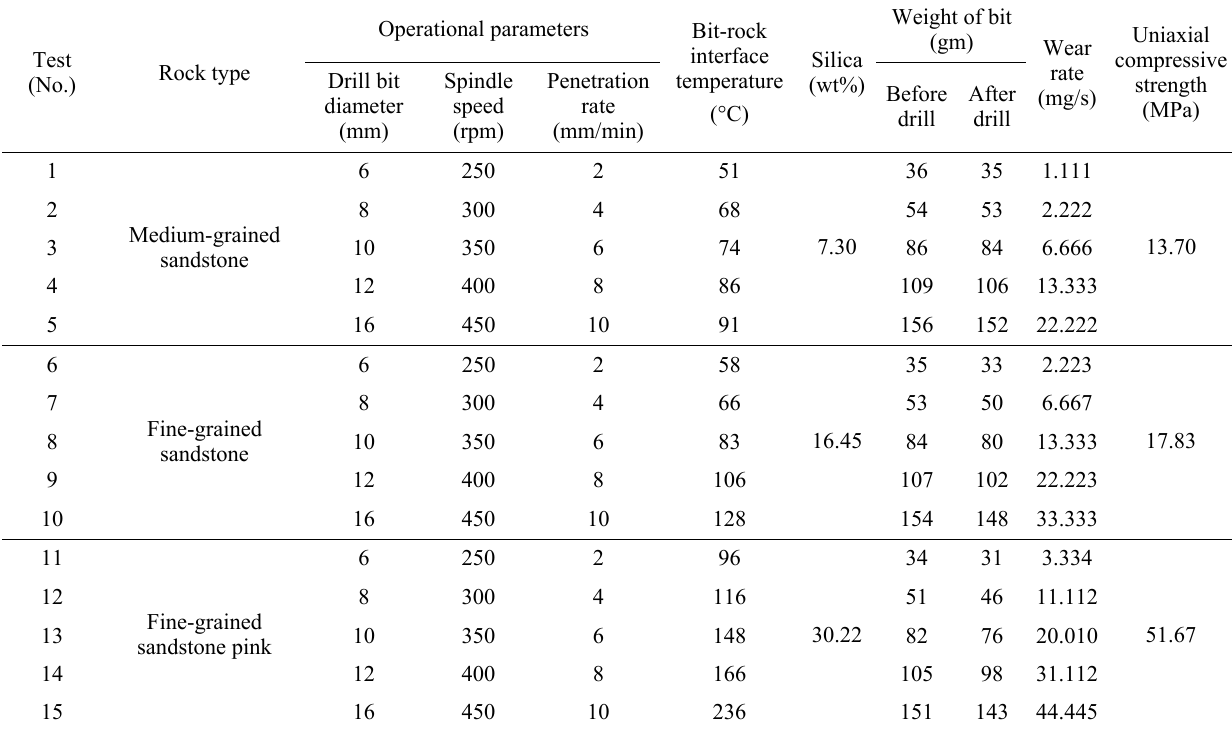
Operational parameters